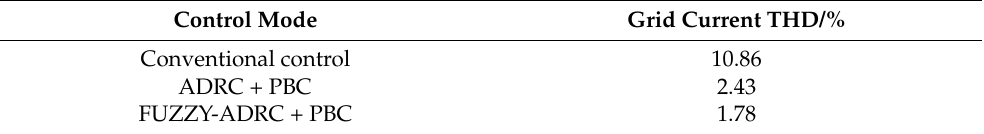
Table 5. THD analysis of grid-connected current under the condition of grid background